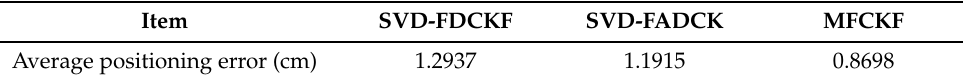
Table 4. Average positioning errors in 1500 Monte Carlo experiments. Item SVD-FDCKF SVD-FADCK Average positioning error (cm)